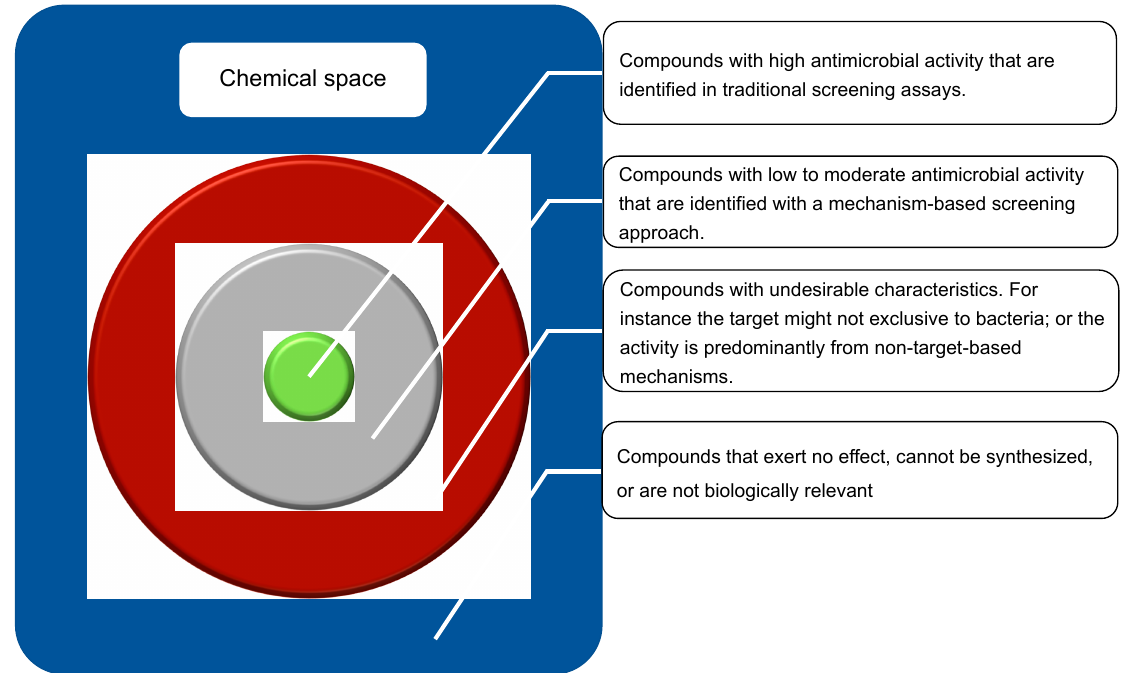
Figure 1. Representation of the chemical space (blue), including relevant subsets, such as those have undesirable characteristics for antibiotics (red), those that induce some level of phenotypic modulation but are not detectable with traditional screening (grey), and easily identified compounds with high-antimicrobial activity (green).